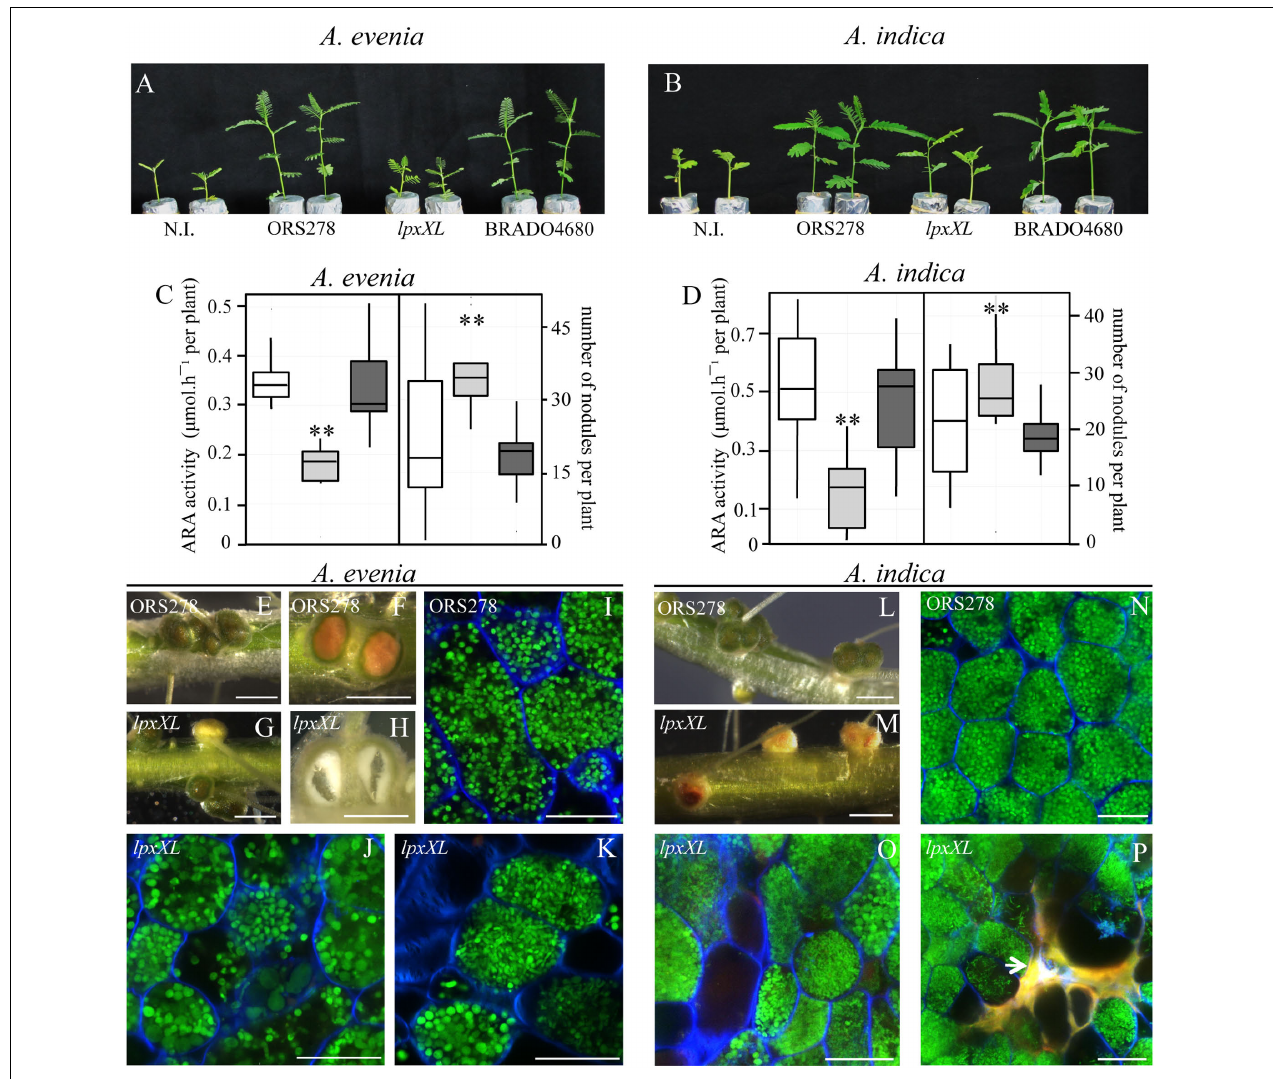
FIGURE 5 | The lpxXL mutant of ORS278 is drastically impaired in symbiosis with Aeschynomene plants. Comparison of the growth of A. evenia (A) and A. indica (B) (aerial part), non-inoculated (N.I.) or inoculated with ORS278, lpxXL or BRADO4680 mutants. (C,D) Box plots representation of the quantification of acetylene reduction activity (ARA) and number of nodules per plant inoculated with ORS278 (white), lpxXL (gray) or BRADO4680 (dark gray) mutants in A. evenia (C) and A. indica (D) . The experiment was carried out in duplicate with 10 plants per condition; Tukey’s honestly significant difference test indicates a significant effect ( ∗ P < 0.1; ∗∗ P < 0.01). (E–H,L,M) Whole roots of A. evenia (E–H) and A. indica (L,M) inoculed with ORS278 (E,F,L) or the lpxXL mutant (G,H,M) ; (F,H) cut nodules; scale bars: 2 mm. (I–K,N–P) Confocal microscopy observations of nodules from A. evenia (I–K) and A. indica (N–P) elicited by ORS278 (I,N) , or the lpxXL mutant (J,K,O,P) ; scale bars: 20 µ m. (P) The white arrow indicates a plant defense